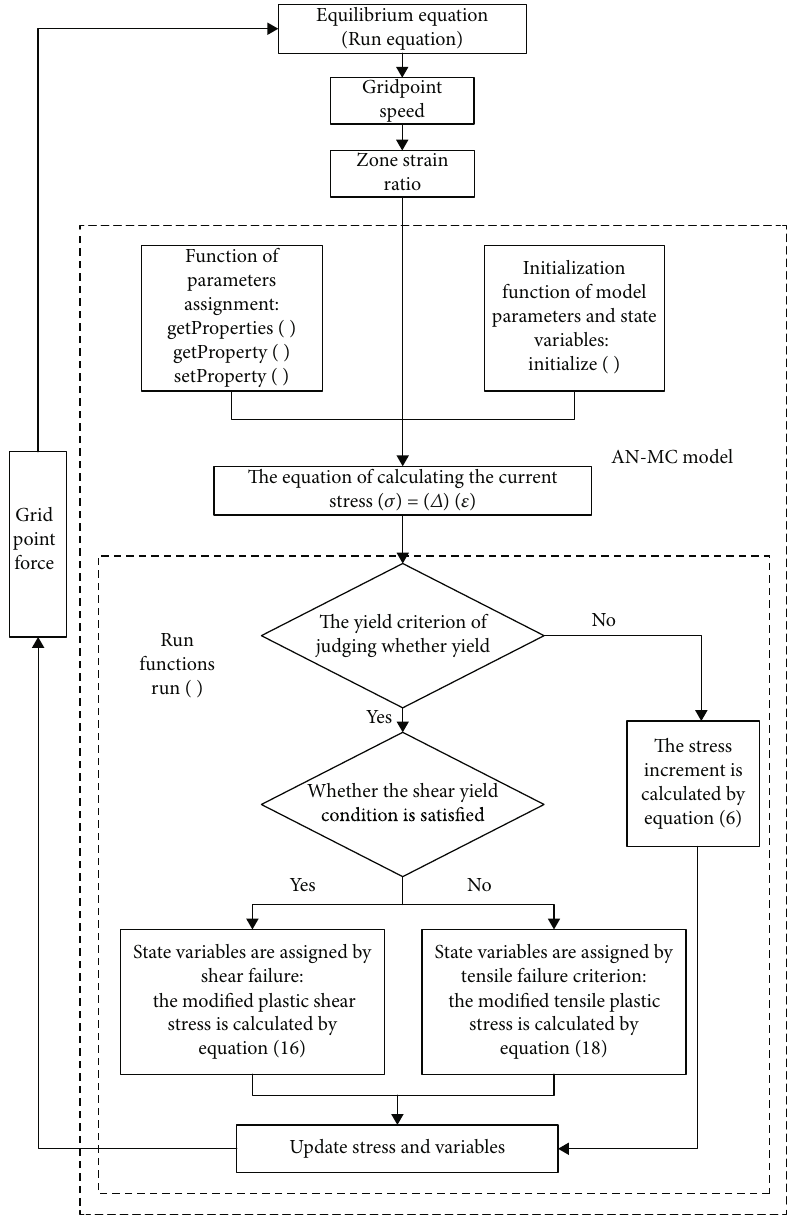
Figure 2: FLAC 3D calculation